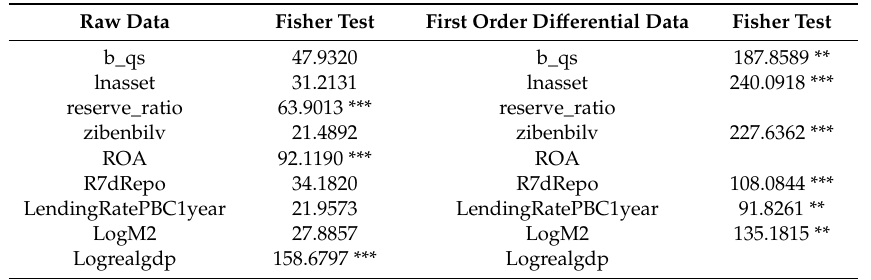
Table 4. Panel unit root test